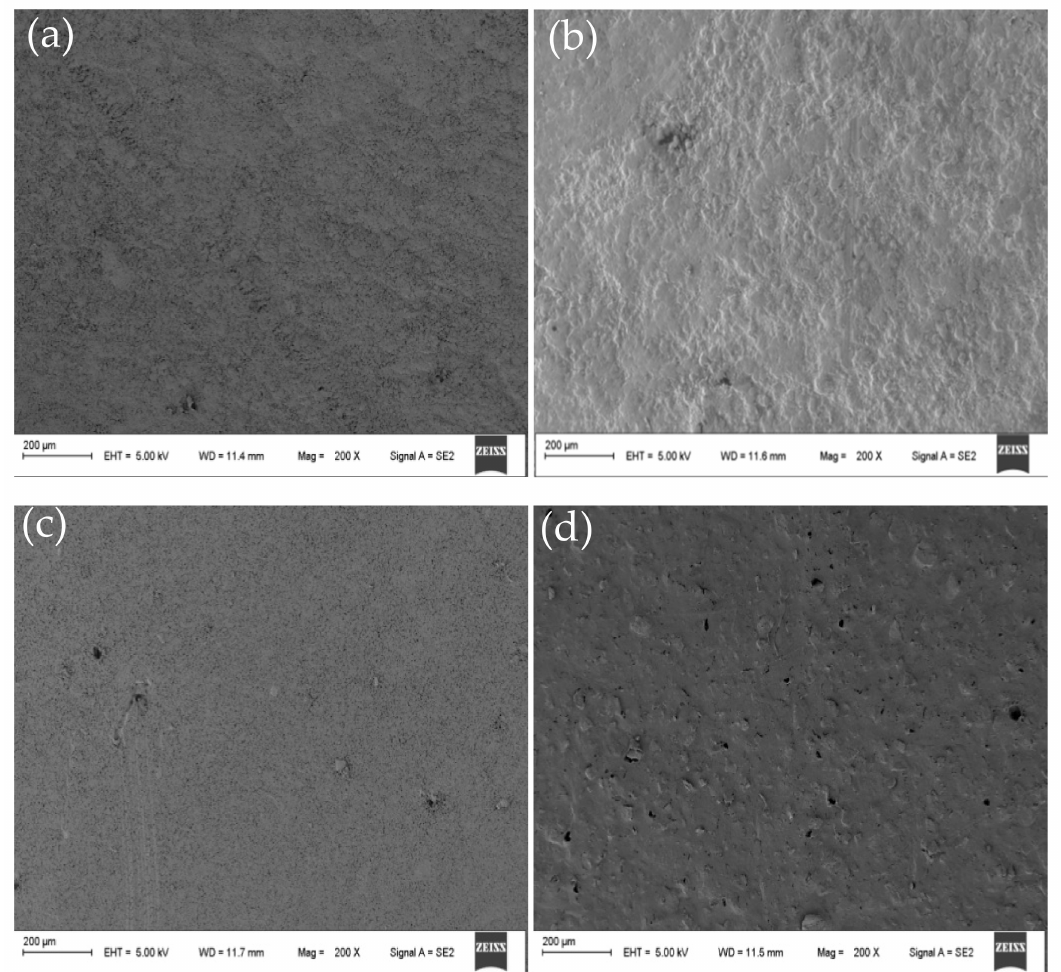
Figure 5. Representative SEM micrographs showing the surface morphology of the organic–inorganic hybrid PVDF-SiO 2 -4 ( a ), PVDF-SiO 2 -6 ( b ), PVDF-SiO 2 -8 ( c ), and Ionsep-HC-C ( d )